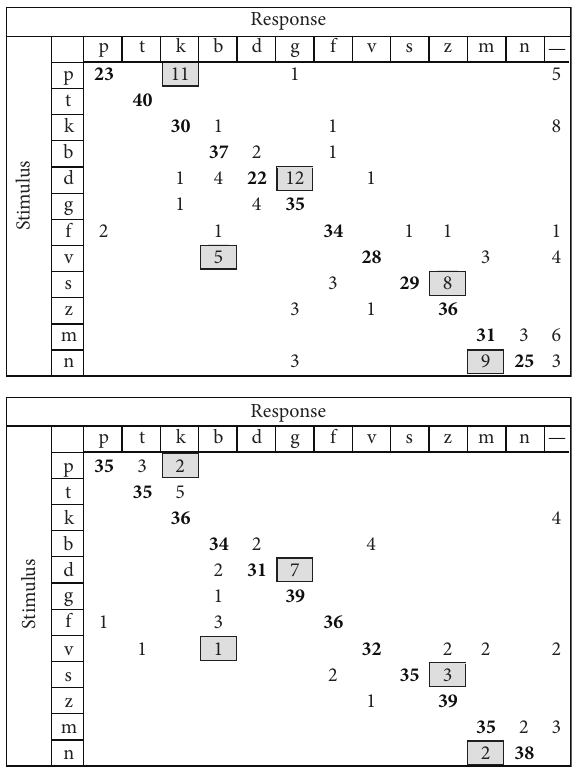
Figure 8: Confusion matrix for Duration group. Baseline is on top, posttraining at the bottom. Significant confusions in baseline have been marked in grey, and this is carried over to the posttraining matrix for easier visual identification of confusion